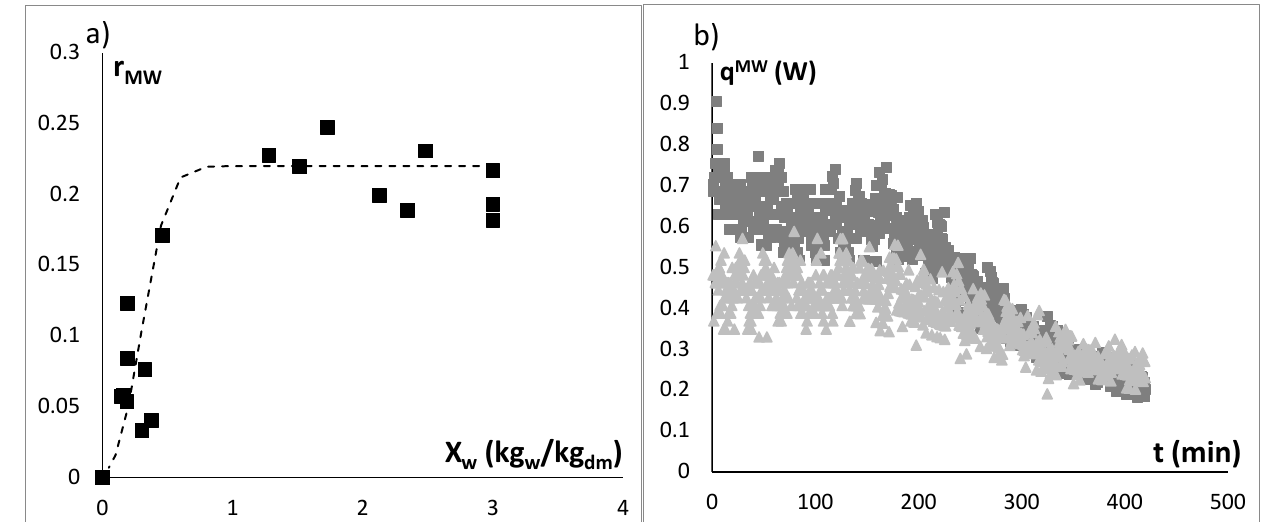
Figure 7. Microwave sample effect: ( a ) The relationship between the microwave energy distribution ratio and the sample moisture expressed on a dry basis and ( b ) microwave heating throughout the drying time for HAD + 4 W/g ( ▲ ) and HAD + 6 W/g ( ■ ) treatments.